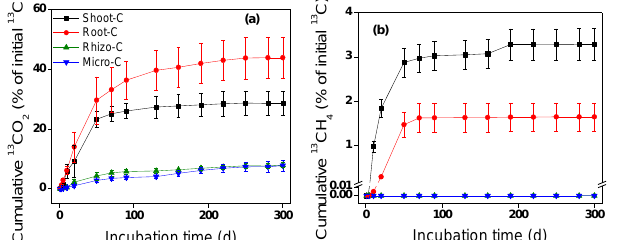
Figure 3. Rates of CO 2 -C and CH 4 -C emissions from shoot-C- (a) and root-C-treated (b) soils over the 300-day incubation period. Values and error bars represent means ± SE ( n = 4). Shoot-C, 13 C- labelled shoot residue; root-C, 13 C-labelled root residue; SOC, soil organic carbon; CK, unlabelled and unplanted soil without supple-